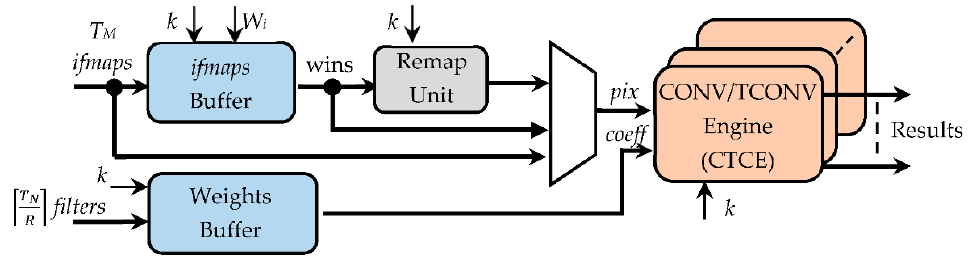
Figure 6. The architecture of the CONV/TCONV unit.